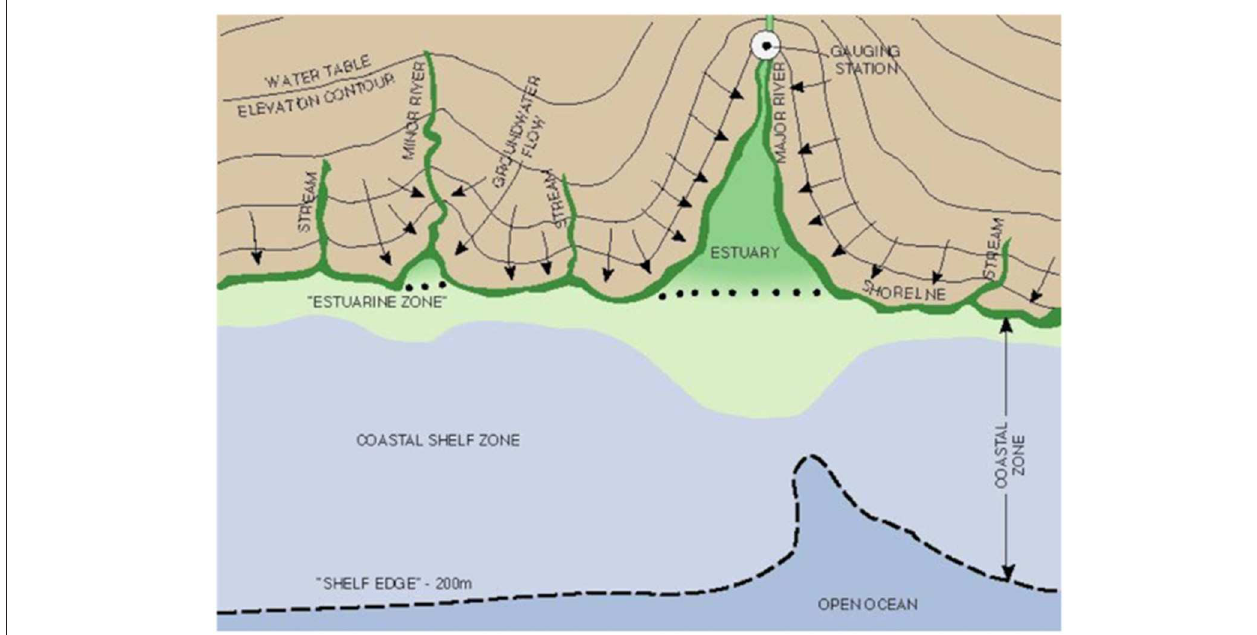
FIGURE 1 | Schematic of the coastal zone showing water table contours and terrestrial groundwater flow paths. This illustrates how groundwater flow driven by hydraulic gradients is focused in river valley estuaries and dispersed at highlands. Note that the groundwater contours and flow paths shown control only the terrestrially-driven flow. Marine, geophysical and biological forces contribute substantially to the total flow through coastal sediments. Also note that the gauging station, located well upstream to eliminate tidal effects, will miss all the groundwater discharged below the gauge (Buddemeier,